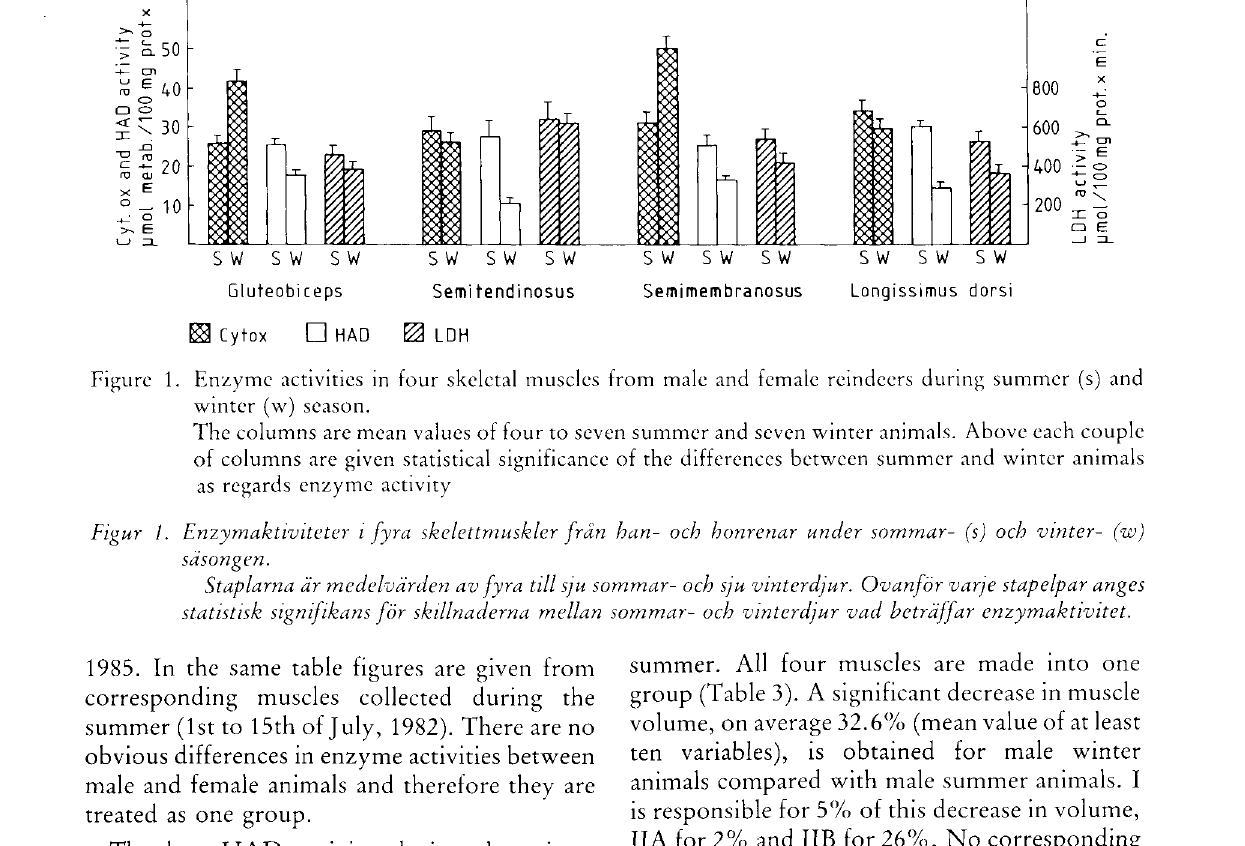
i fyra skelettmuskler från han- och honrenar under sommar- (s) och vinter- (w)